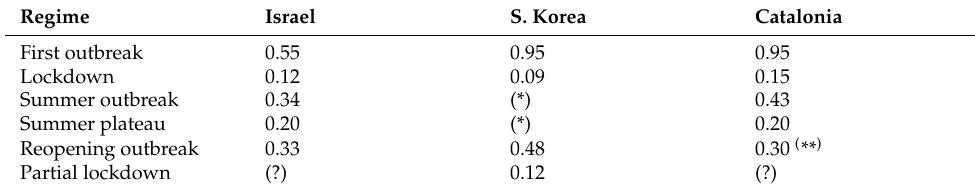
Table 4. β comparison. (*) In South Korea, the summer outbreak is so low that the model is not proper. (**) The forecast of a new outbreak with a β close to Israel proved to be accurate. (?) Information is not yet available, or the situation did not occur at the time of analysis of model 2.5.